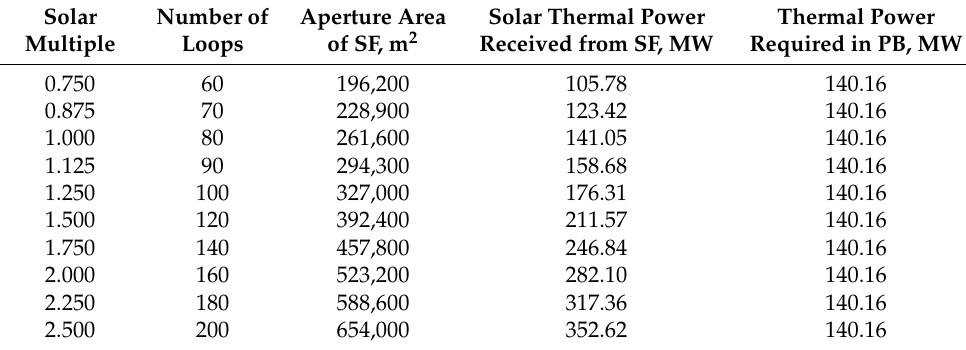
Table 5. Calculation of solar multiple.